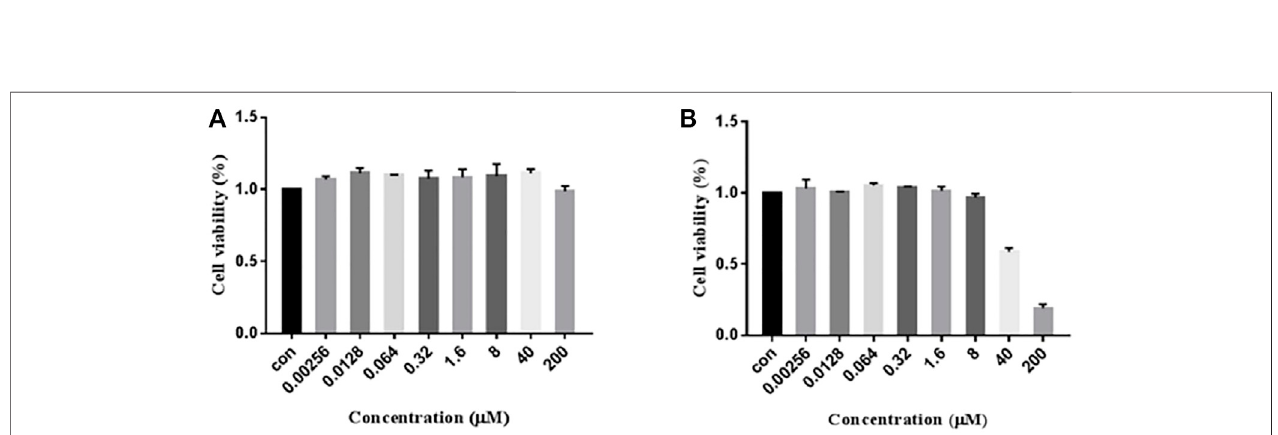
FIGURE 5 | Compounds inhibit OGD/R-induced cell apoptosis. Flow cytometry images show that OGD/R-induced apoptosis in PC12 cells was rescued by the candidate compound (AK: 3.125 μ M; 797: 1.5625 μ M; Z11: 1.5625 μ M). Each bar represents the mean ± standard deviation (SD) calculated from three independent experiments. ## p < 0.01 vs. control group; * p < 0.05 vs. OGD/R group.